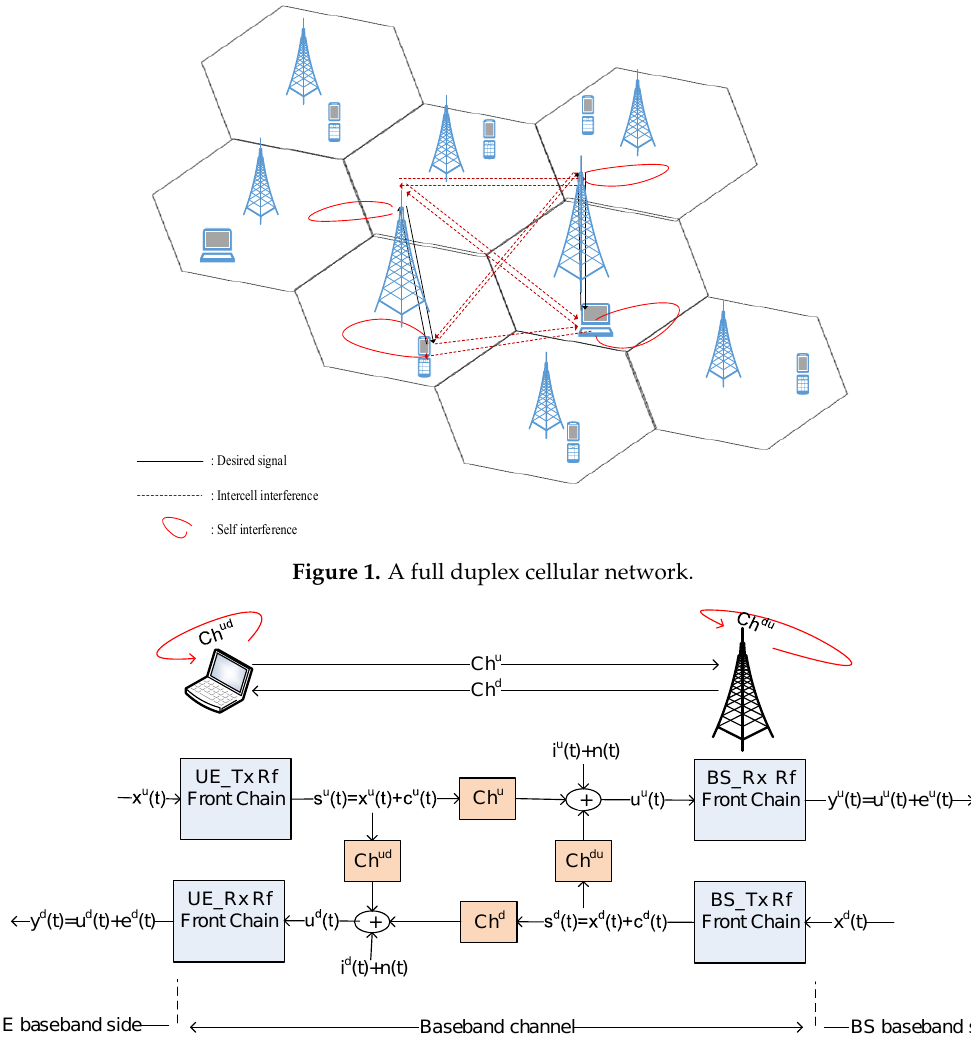
Figure 2. A full duplex baseband-equivalent system for both uplink and downlink